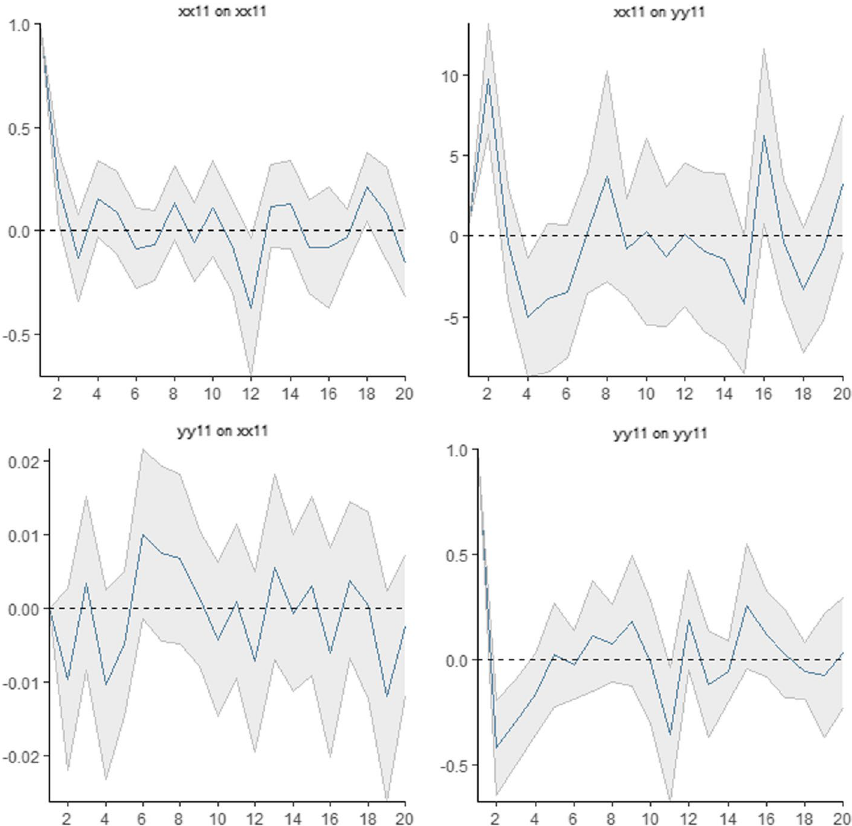
Fig. 13 The subperiod analysis of high-return regime for the period in which CPI < IR (Positive interest rates) (11.01.2018–11.29.2019). Note : Grey shaded area illustrates 95% confidence intervals. The figures from top to bottom correspond to linear analysis, low return regime, high return regime